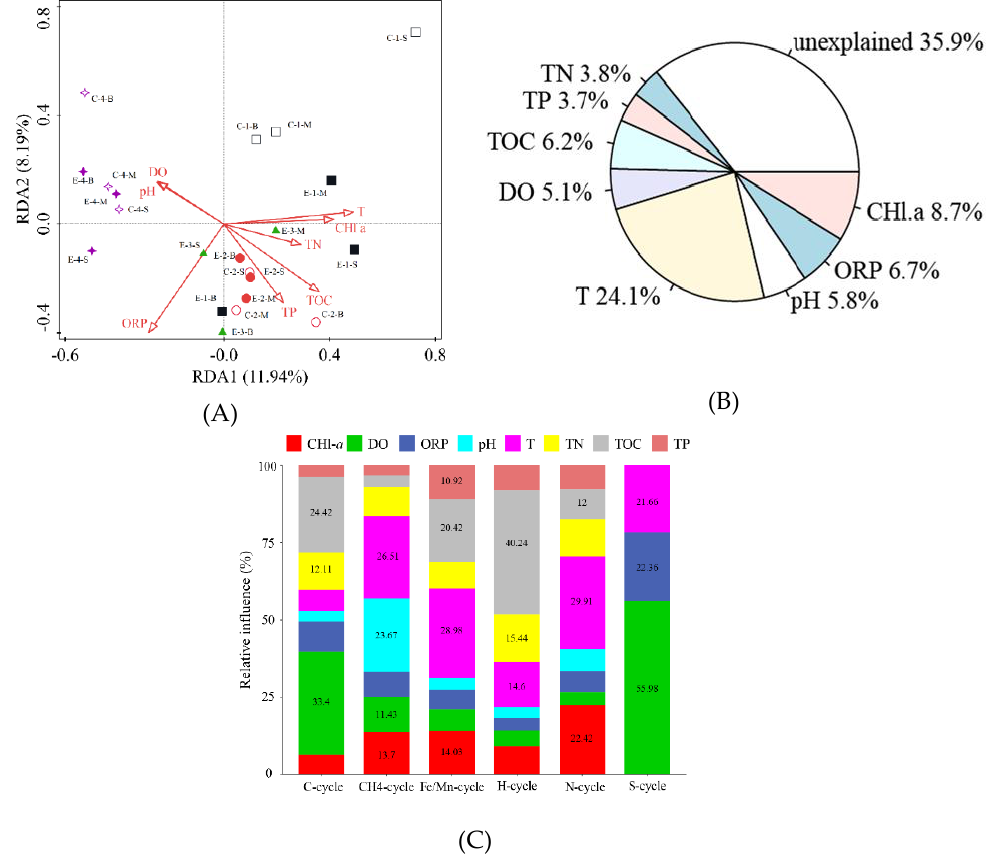
Figure 9. Relationship between environmental factors and microbial communities in Jinpen Reservoir: ( A ) redundancy analysis (RDA); ( B ) hierarchical partitioning analysis; ( C ) aggregated boosted tree (ABT) for functional bacteria.